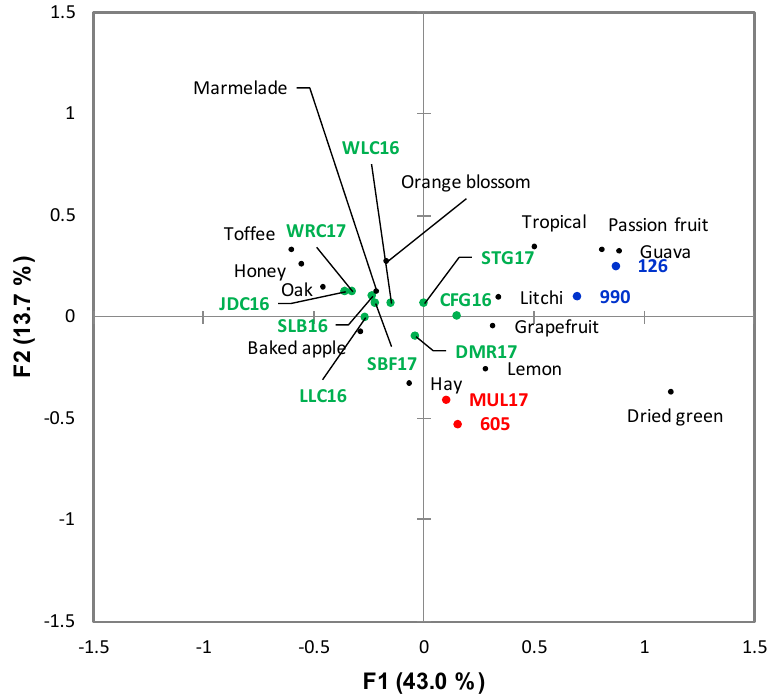
Figure 8. Correspondence Analysis biplot of the CATA results for the Chenin Blanc wines illustrating the sensory space of the samples evaluated. The samples are color-coded according to the HCA clusters from Figure 6. Only significant attributes are represented ( p < 0.05). The wine codes are as indicated in the text.